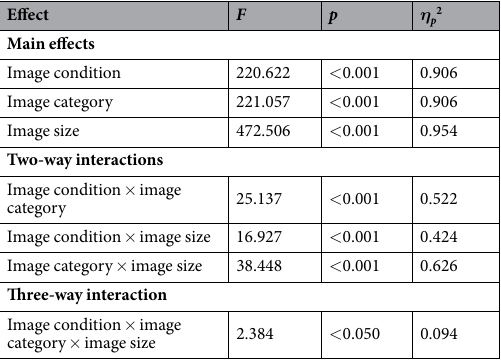
Table 9. Results of the 2 × 3 × 5 (image condition × image category × image size) ANOVA for saccade